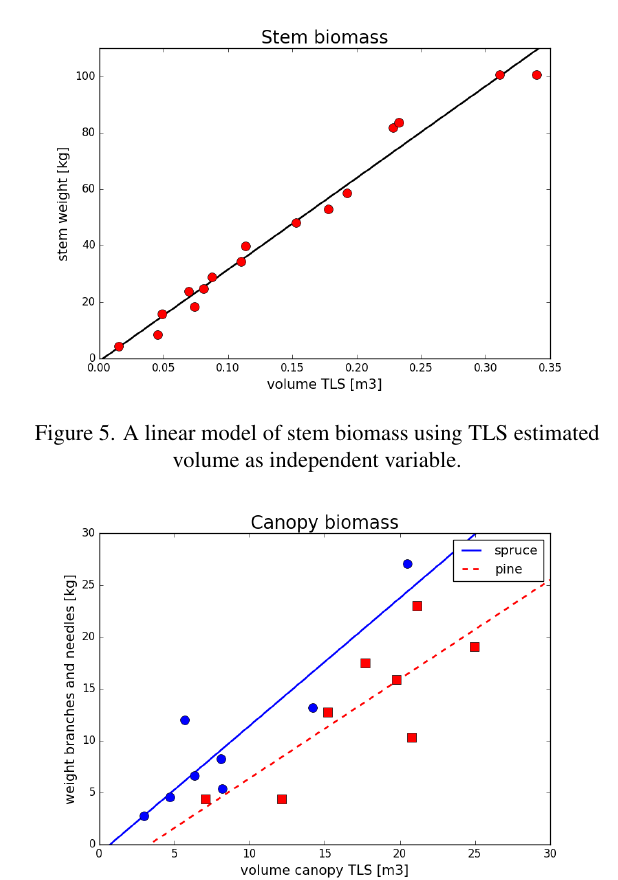
Figure 6. A linear model of canopy biomass (branches and